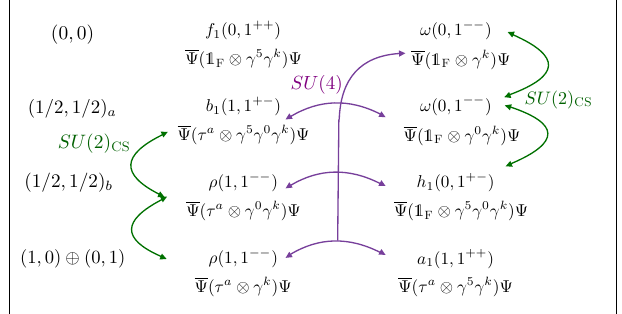
Figure 3. The green arrows connect operators that belong to SU ( 2 ) CS triplets. The purple arrow shows the SU ( 4 ) 15-plet. The f 1 operator is a singlet of SU ( 4 ) . The figure is from Ref.